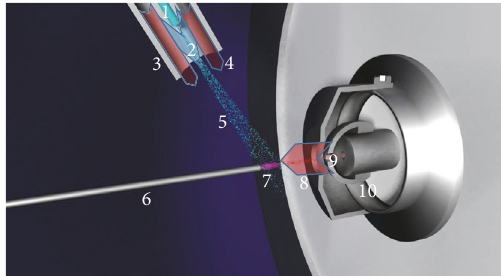
Figure 2: Schematic drawing of the APCI source in front of the MS inlet. 1: sprayer; 2: nebulizer gas (blue arrow); 3: heater; 4: auxiliary gas (red arrow); 5: vaporized spray; 6: corona needle; 7: corona discharge; 8: dry gas (red arrow); 9: ions (red dots); 10: MS inlet.